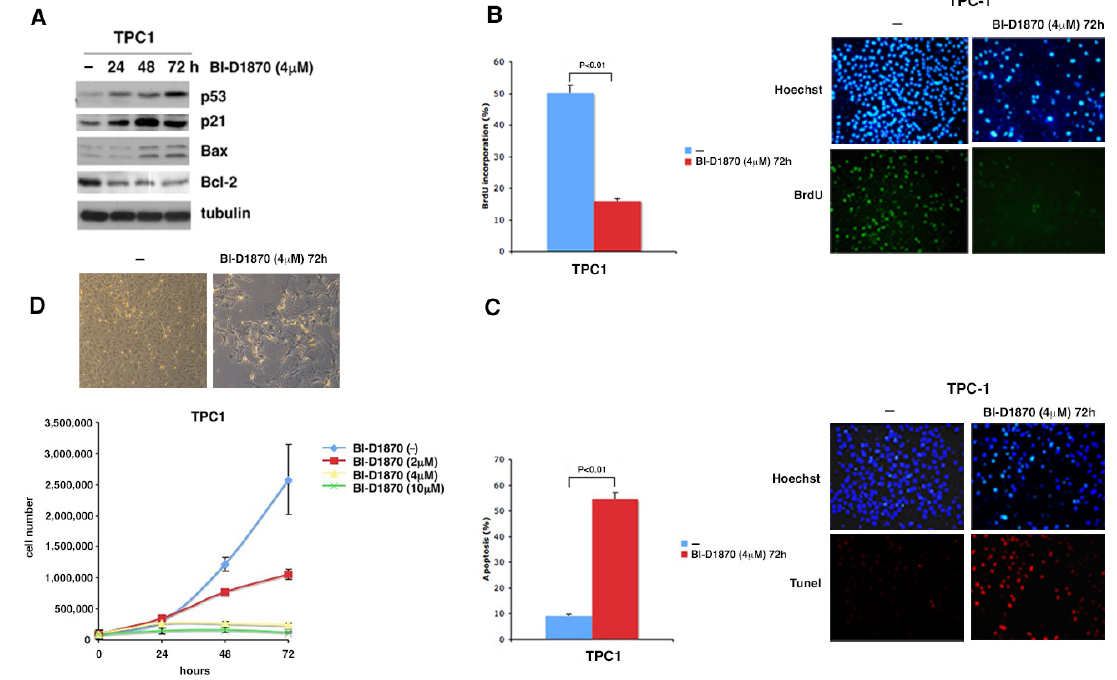
Figure 5. p90RSK is able to regulate proliferation and apoptosis by controlling p53 levels. ( A ) TPC1 cells were treated with 4 µ M BI-D1870 in the indicated times (h). The immunoblot was tested with anti-p53, anti-p21, anti-Bax, anti-Bcl2 antibodies and normalized with the anti-tubulin antibody; ( B ) BrdU assay in TPC1 cells treated or not with 4 µ M BI-D1870 for 72 h. Nuclei were stained with Hoechst (blue stain) and apoptotic cells were highlighted by anti-BrdU antibody (green stain). At least 500 cells per sample were counted. The percentage of BrdU positive cells was calculated as the ratio of BrdU-labeled nuclei to total nuclei. The experiment was conducted in triplicate. The histogram represents the mean value of positive BrdU cells among those counted in multiple fields (more than 100 cells counted in each field). The error was calculated with the standard deviation of the obtained values (left panel). The cells were photographed using a fluorescence microscope at 10 × magnification. One representative field for sample was shown (right panel); ( C ) TUNEL assay in TPC1 cells treated or not with 4 µ M BI-D1870 for 72 h. Total nuclei were stained with Hoechst (blue stain) and apoptotic cells were highlighted by the TUNEL test (red stain). The percentage of apoptotic cells was calculated as the ratio of red-labeled nuclei to total nuclei (blue). The histogram represents the mean value of apoptotic cells among those counted in multiple fields (more than 500 cells counted in total). The error was calculated with the standard deviation of the obtained values (left panel). The cells were photographed using a fluorescence microscope at 10 × magnification. One representative field for sample was shown (right panel); ( D ) growth curve of TPC1 cells treated with different doses of BI-D1870. The experiment was conducted in triplicate. The results in the histogram are the average of the three independent determinations +/ − standard deviation (lower panel). TPC1 cells, treated or not with 4 µ M BI-D1870 for 72 h, were photographed in the optical field at 10 × magnification. A representative field was shown (upper